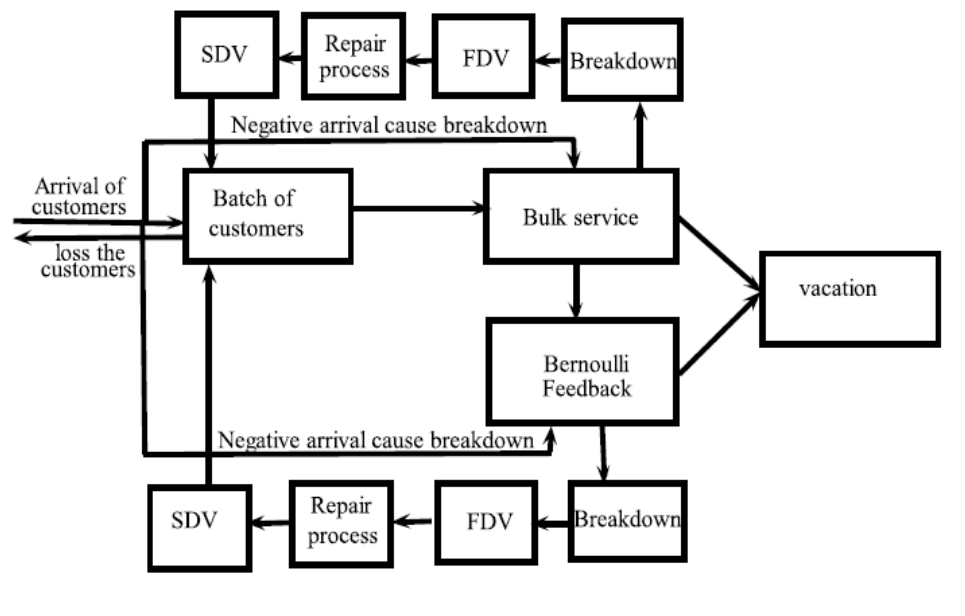
Figure 1. Pictorial representation of the